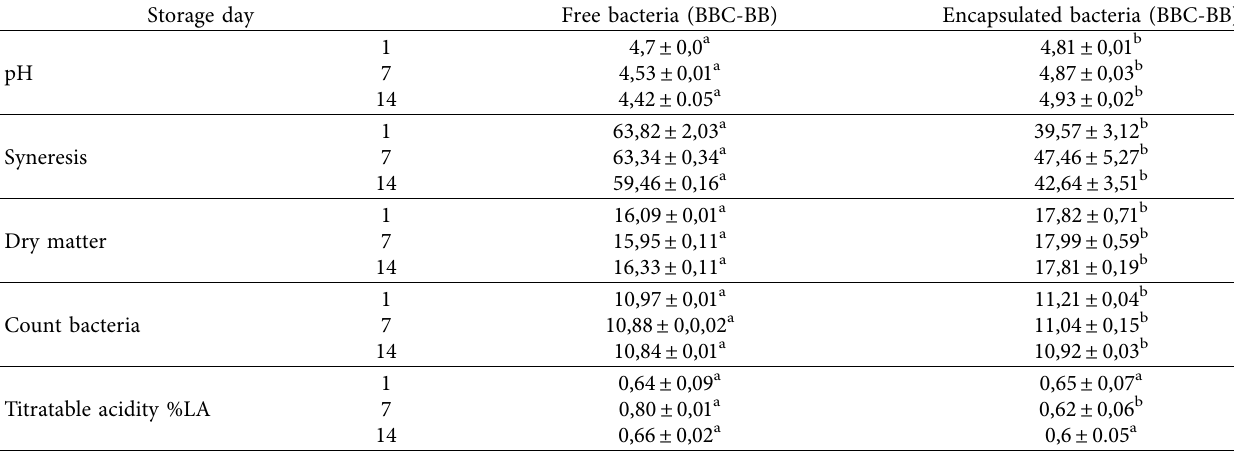
Table 8: pH, titration acidity, syneresis, count bacteria, and dry matter value of yoghurt including encapsulated and free bacteria. Storage day